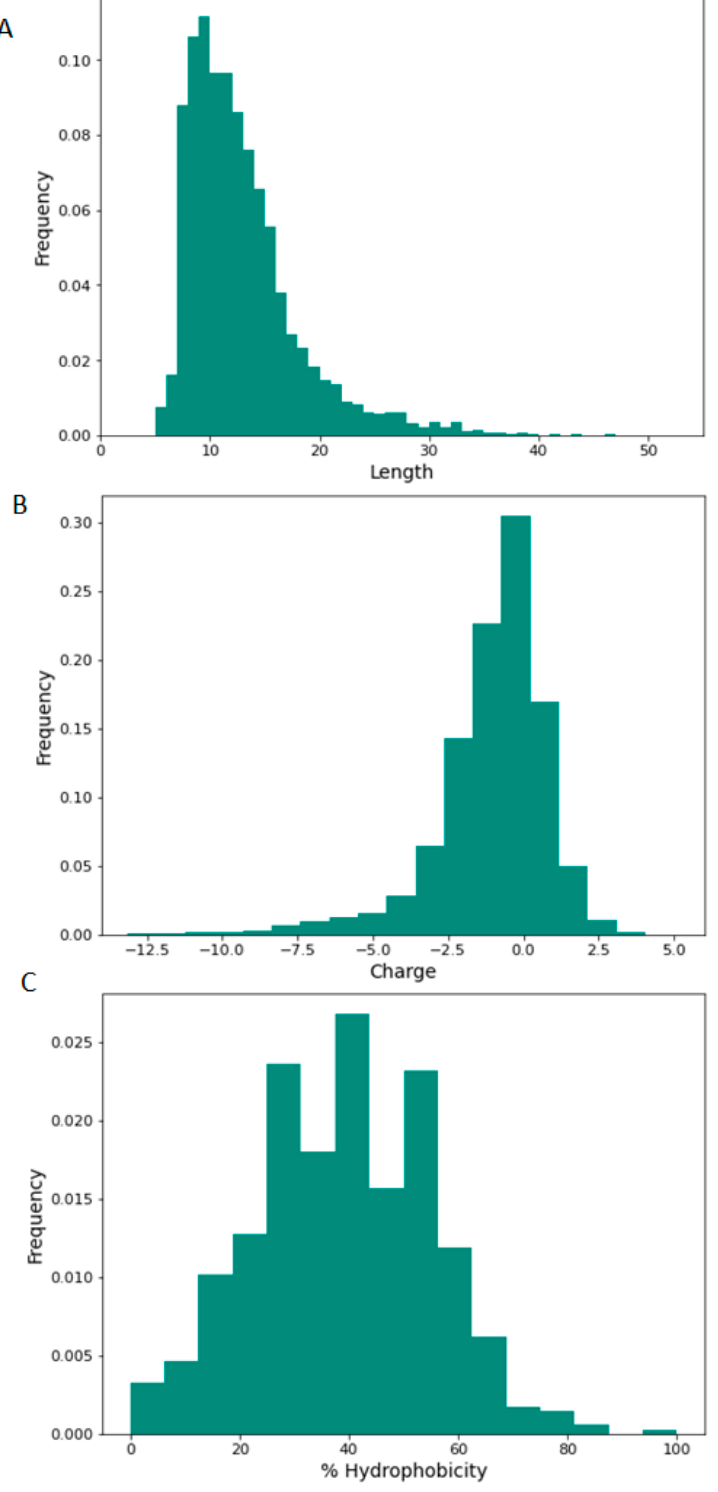
Figure 2. Physicochemical properties of NRT_N0G5IJ peptide profile as determined by LC–MS/MS. Histogram representation of NRT_N0G5IJ peptide distribution according to ( A ) length, ( B ) charge, and ( C ) percentage hydrophobicity; peptide counts are displayed on the y -axis.